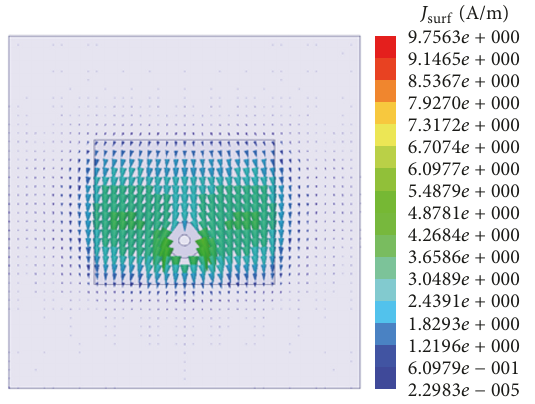
Figure 3: The vector current distribution of 0 degrees on the solid ground plane of the conventional patch antenna.